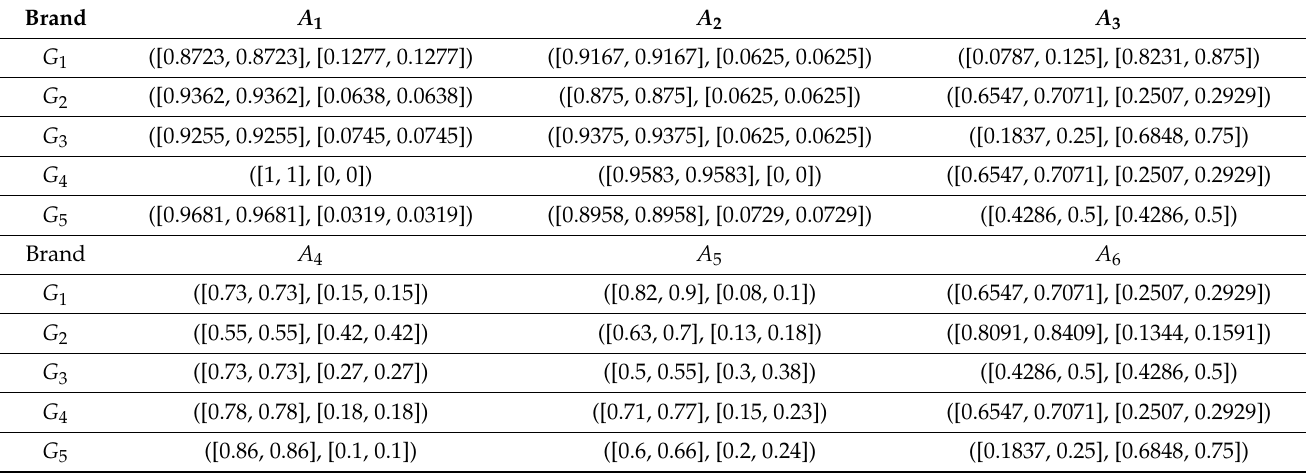
Table 10. The transformed evaluation matrix of expert D 4